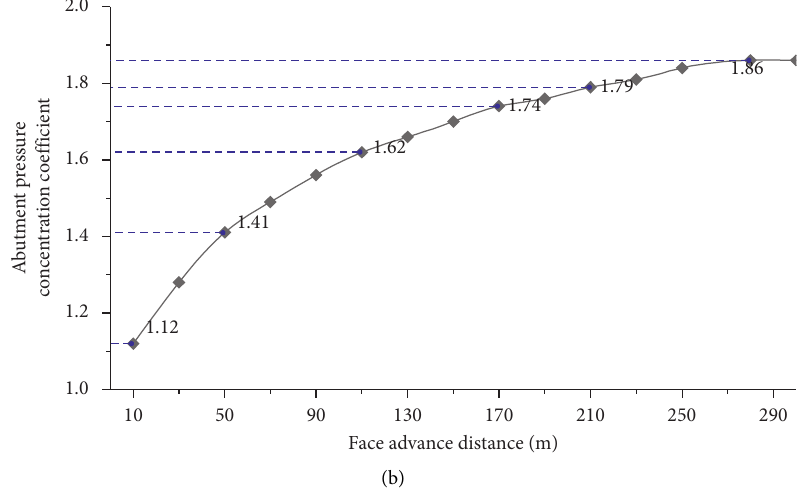
Figure 3: Variation law of abutment pressure. (a) Abutment pressure concentration coefficients in front of coal wall. (b) Change in abutment pressure concentration coefficient with face advance.